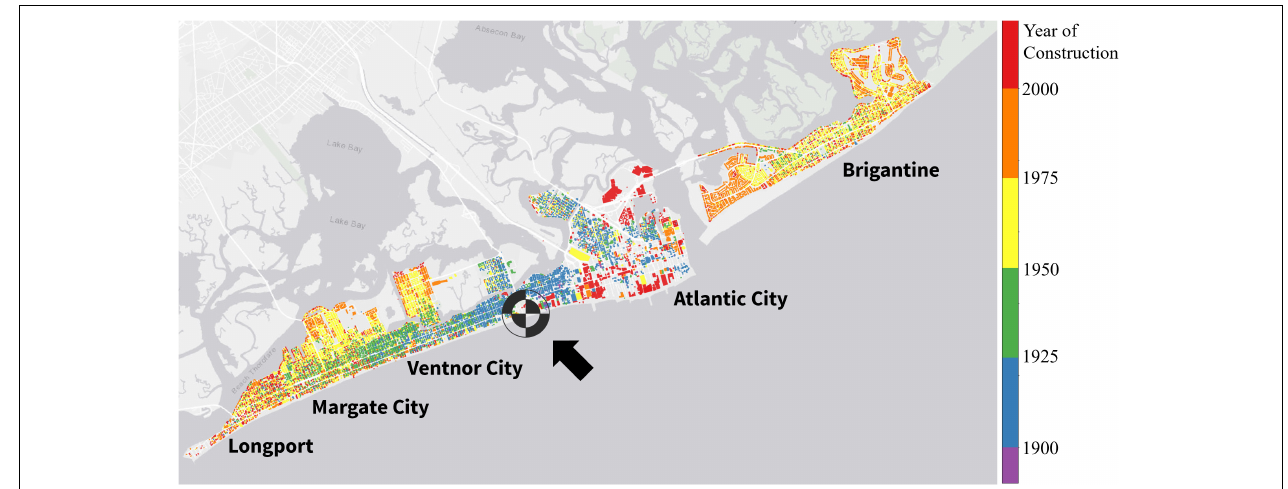
FIGURE 7 | Atlantic City testbed inventory (across five municipalities) by year of construction with landfall location marked by target